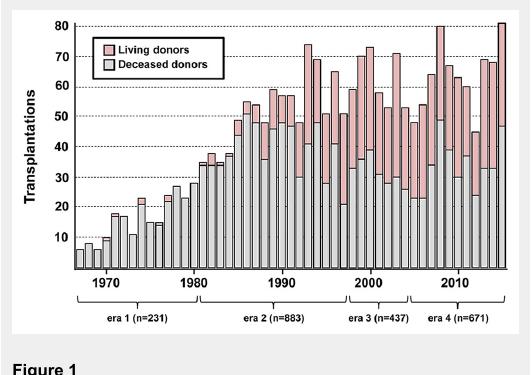
Evolution of age distribution, subdivided into donors and recipients, and grouped according to donor kidney source (living vs deceased). Data are presented as density plots. The darkness of area corresponds to the number of patients.